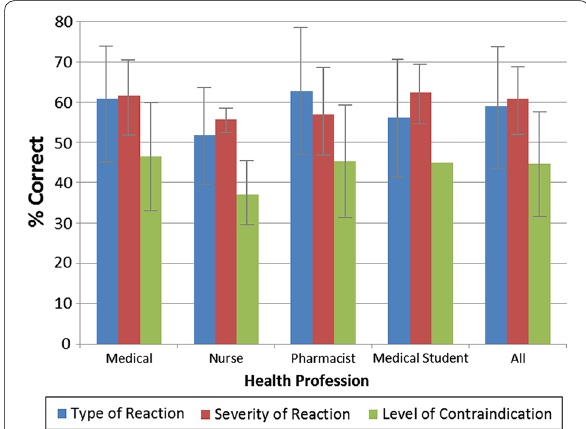
Fig. 1 Proportion of correct responses to clinical scenarios for type, severity of reaction and level contraindication by health